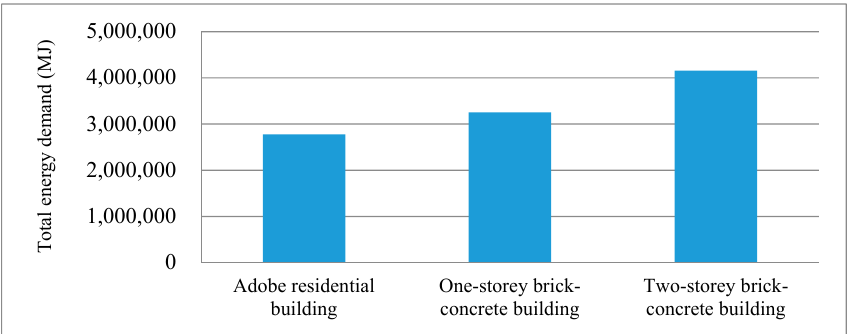
Figure 16. Total energy demand in the full life cycle.